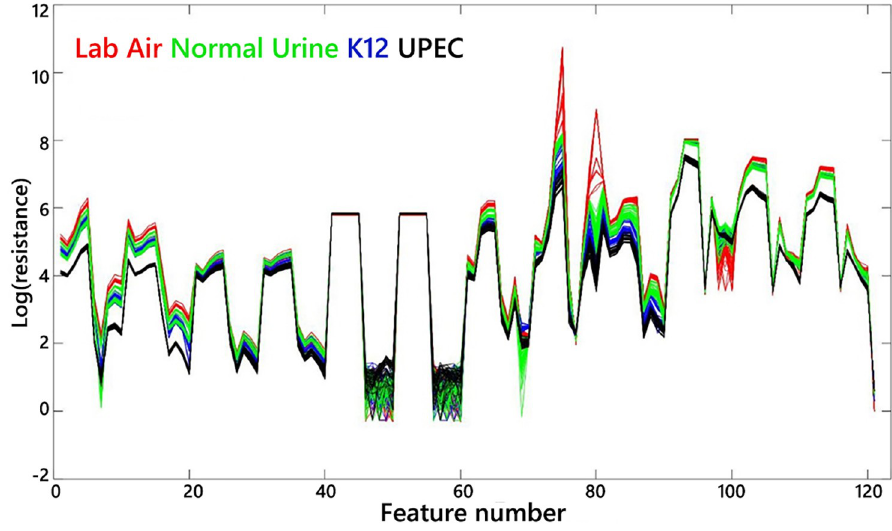
Fig 5. Visualization of VOC fingerprints shows different patterns in electrical resistance across calculated sample features for each sensor.